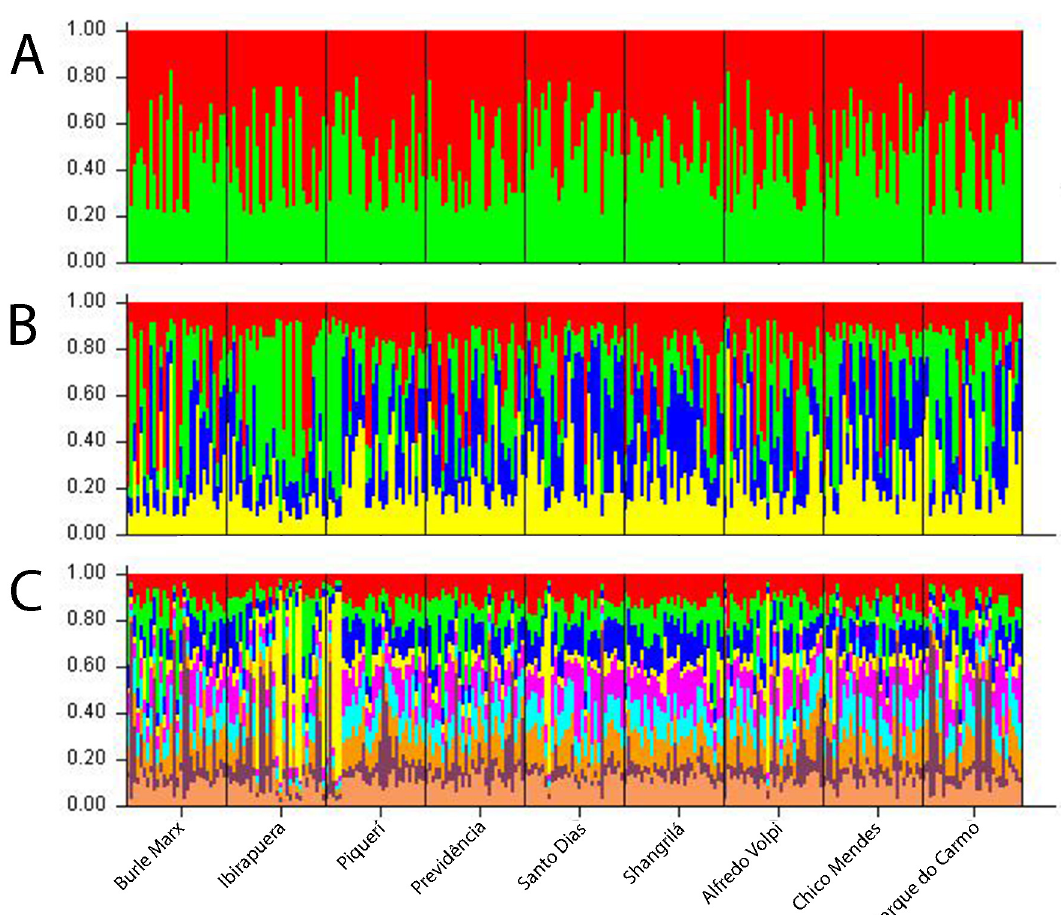
Fig 3. Bayesian analysis of structure for all Aedes fluviatilis populations showing the subdivision of individuals k = 2 (A), k = 4 (B) and k = 9 (C). Each of the 270 individuals from nine populations is represented by a vertical line divided into different colored segments. The length of each segment represents the probability of the individual belonging to the genetic cluster represented by that color.